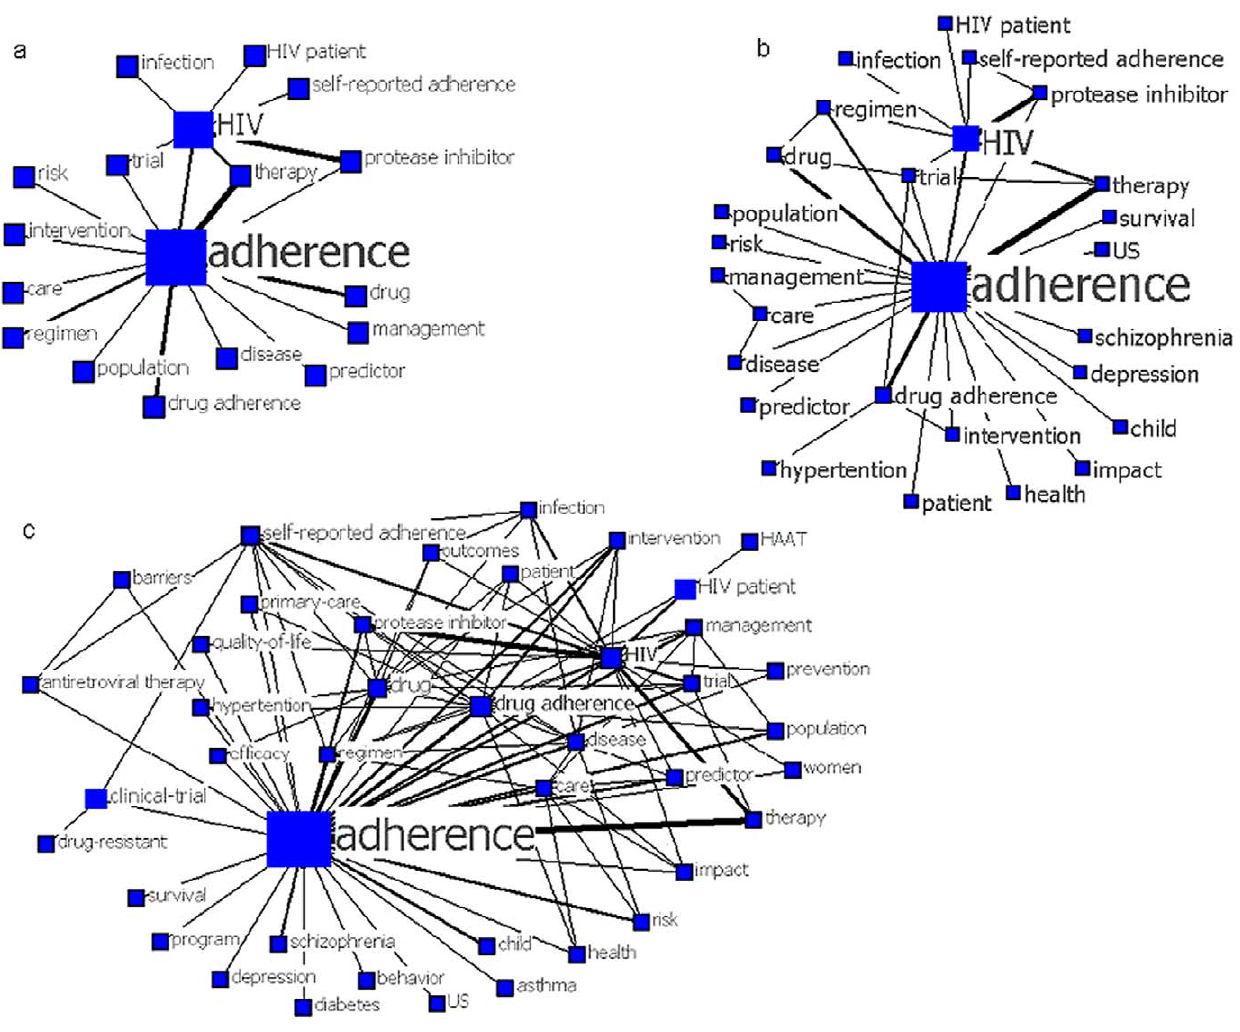
Figure 3. The decomposition maps for keywords in adherence research, 2000–2005. The size of nodes indicates the keywords centrality, and the thickness of the lines indicates the co-occurrence frequency of keywords pairs. The thresholds of co-occurrence frequency in map a ,b and c is $ 15, $ 10 and $ 5, respectively.